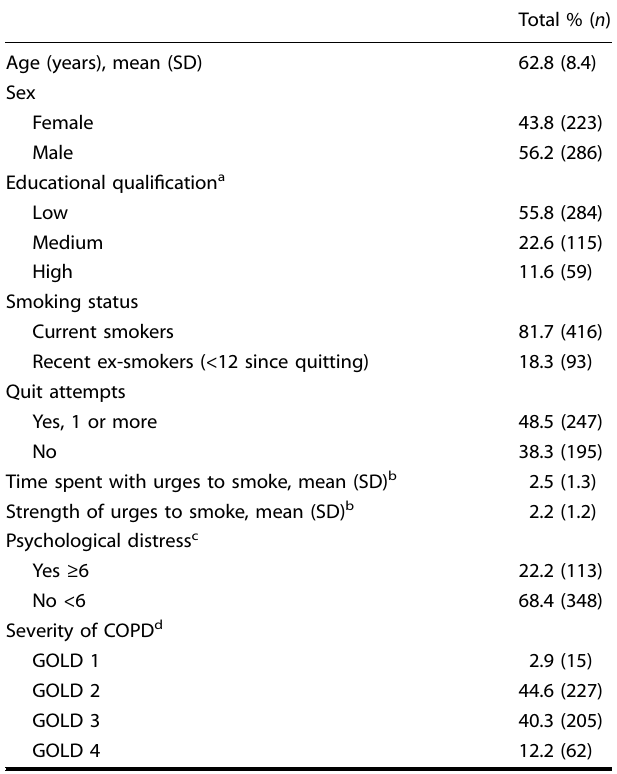
Table 2. Sociodemographic, smoking, and health-related characteristics of 509 past-year smokers with COPD (FEV1/FVC <